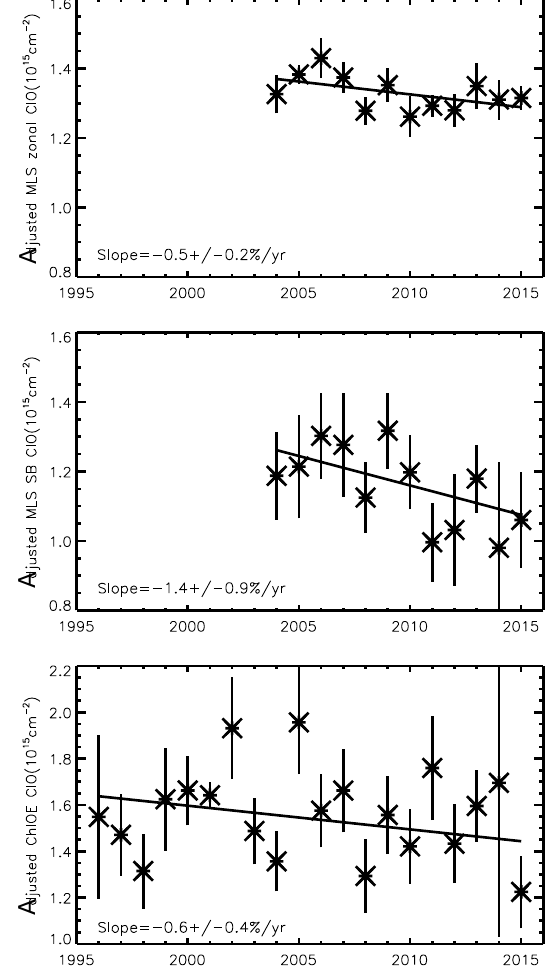
Figure 9. The annual average temperature-adjusted ClO columns (see text) for 28 August to 17 September. The adjustment is based upon the annual average temperature and the relationship shown in Fig. 8 (see text). Results are shown for the zonally averaged MLS measurements within ± 2 ◦ latitude of Scott Base (top), for MLS measurements within ± 2 ◦ latitude and ± 15 ◦ longitude of Scott Base (middle), and for ChlOE measurements at Scott Base (bot- tom). Also shown is a linear fit to the data. Uncertainties are 1 σ